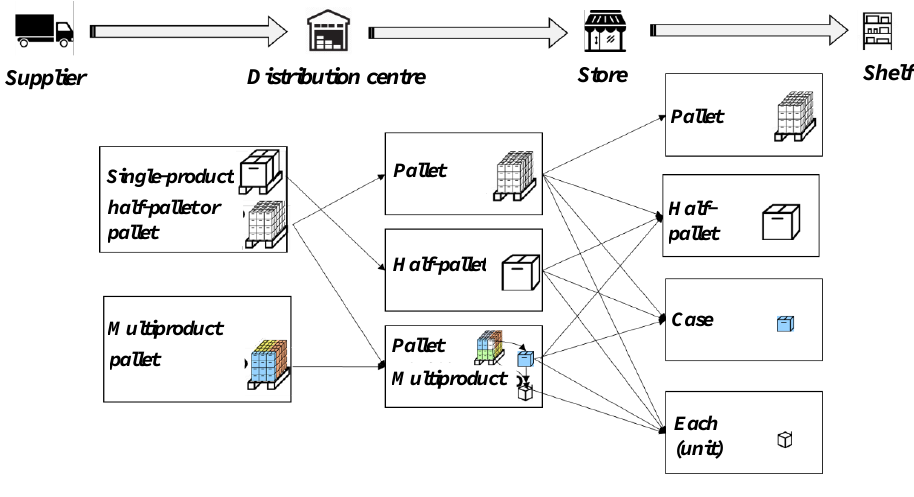
Figure 1. Variations of the handling unit along the company’s supply